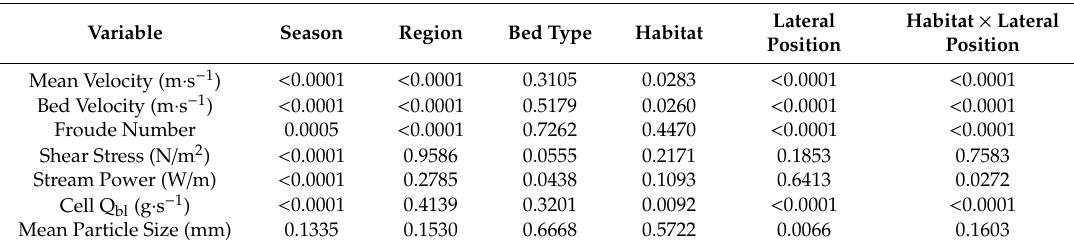
Table 5. Resulting p -values from ANOVA statistics by variable and e ff ect for energy and sediment regime